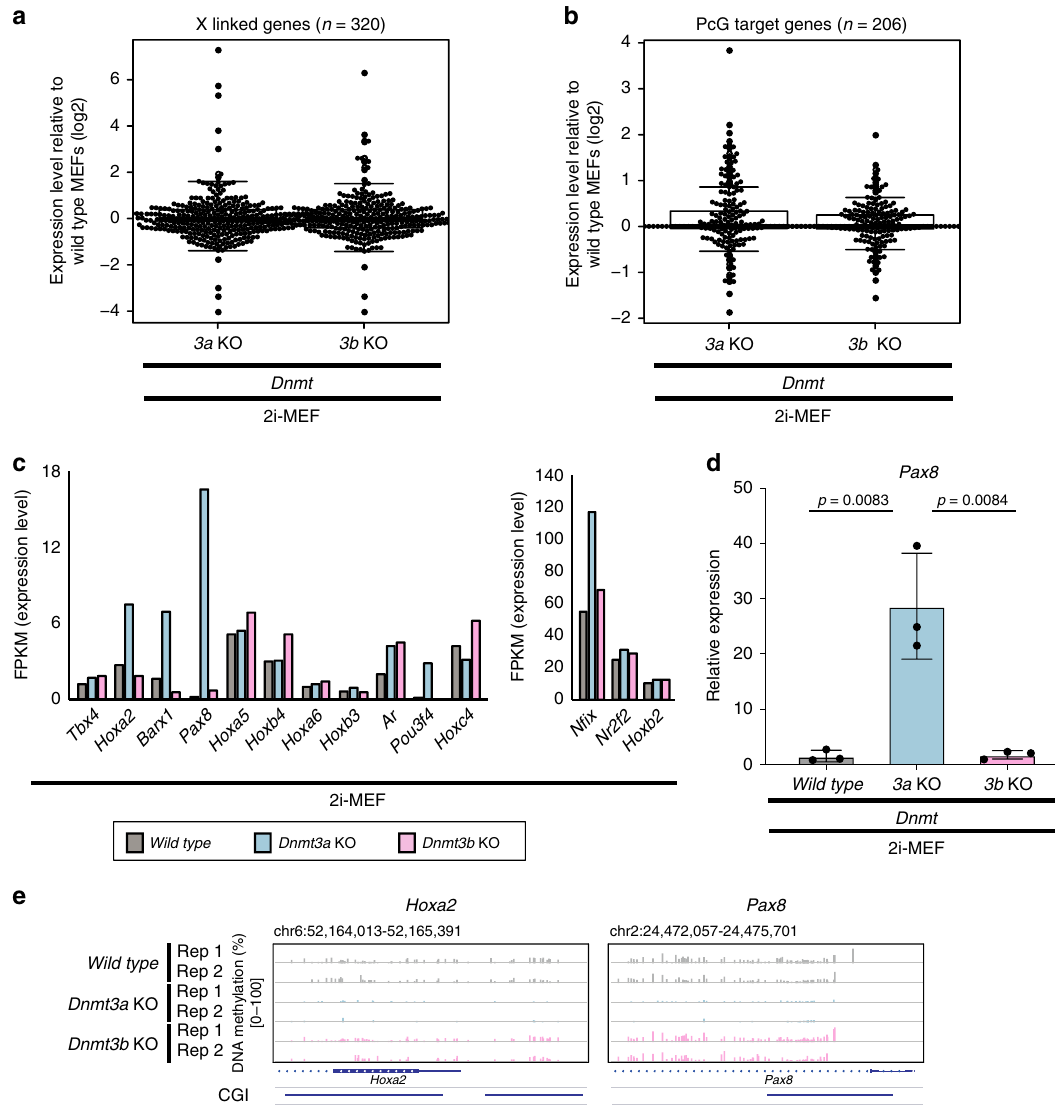
Fig. 4 Derepression of PcG target genes in Dnmt3a KO 2i-MEFs. a Relative gene expression levels (FPKM + 1) of X-linked genes ( n = 320) in Dnmt3 KO 2i-MEFs ( n = 1) vs. WT 2i-MEFs ( n = 1), as determined by RNA-seq. Note that expression levels of most X-linked genes were comparable, regardless of Dnmt3 status. Solid lines in each box indicate the median. The bottom and top of the boxes are lower and upper quartiles, respectively. Whiskers extend to ±1.5 IQR. b Relative gene expression levels (FPKM + 1) of PcG target developmental genes ( n = 206) in Dnmt3 KO 2i-MEFs ( n = 1) vs. WT 2i-MEFs ( n = 1), as determined by RNA-seq. Note that most PcG target genes were expressed at similar levels. Only a small subset of genes was modestly upregulated in Dnmt3 KO 2i-MEFs. c Expression level (FPKM) of PcG target genes, as determined by RNA-seq. Genes methylated more than 15% at TSS ± 1000 bp in